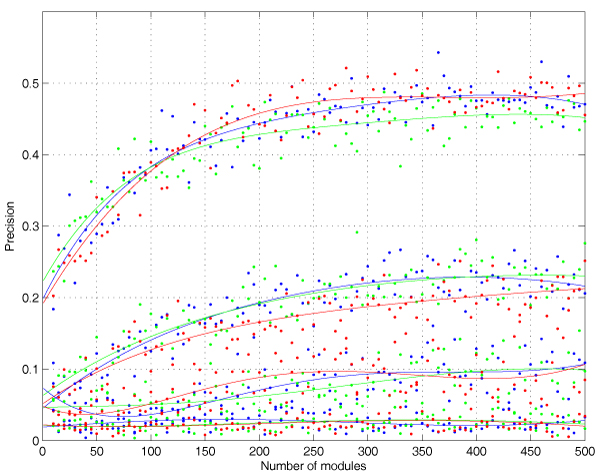
Precision at different regulation tree levels. Precision as a function of the number of modules for subnetworks generated by regulation tree levels 0 (roots), 1 and 2, and for random assignments of regulators to regulation tree nodes (top to bottom) for data sets with 100 (red), 200 (green) and 300 (blue) experiments. The curves are least squares fits of the data to a linear non-polynomial model of the form a0+∑k=1nakxk−1e−x/500
 MathType@MTEF@5@5@+=feaafiart1ev1aaatCvAUfKttLearuWrP9MDH5MBPbIqV92AaeXatLxBI9gBaebbnrfifHhDYfgasaacH8akY=wiFfYdH8Gipec8Eeeu0xXdbba9frFj0=OqFfea0dXdd9vqai=hGuQ8kuc9pgc9s8qqaq=dirpe0xb9q8qiLsFr0=vr0=vr0dc8meaabaqaciaacaGaaeqabaqabeGadaaakeaacqWGHbqydaWgaaWcbaGaeGimaadabeaakiabgUcaRmaaqadabaGaemyyae2aaSbaaSqaaiabdUgaRbqabaGccqWG4baEdaahaaWcbeqaaiabdUgaRjabgkHiTiabigdaXaaakiabdwgaLnaaCaaaleqabaGaeyOeI0IaemiEaGNaei4la8IaeGynauJaeGimaaJaeGimaadaaaqaaiabdUgaRjabg2da9iabigdaXaqaaiabd6gaUbqdcqGHris5aaaa@461A@ with x the number of modules and n = 3.